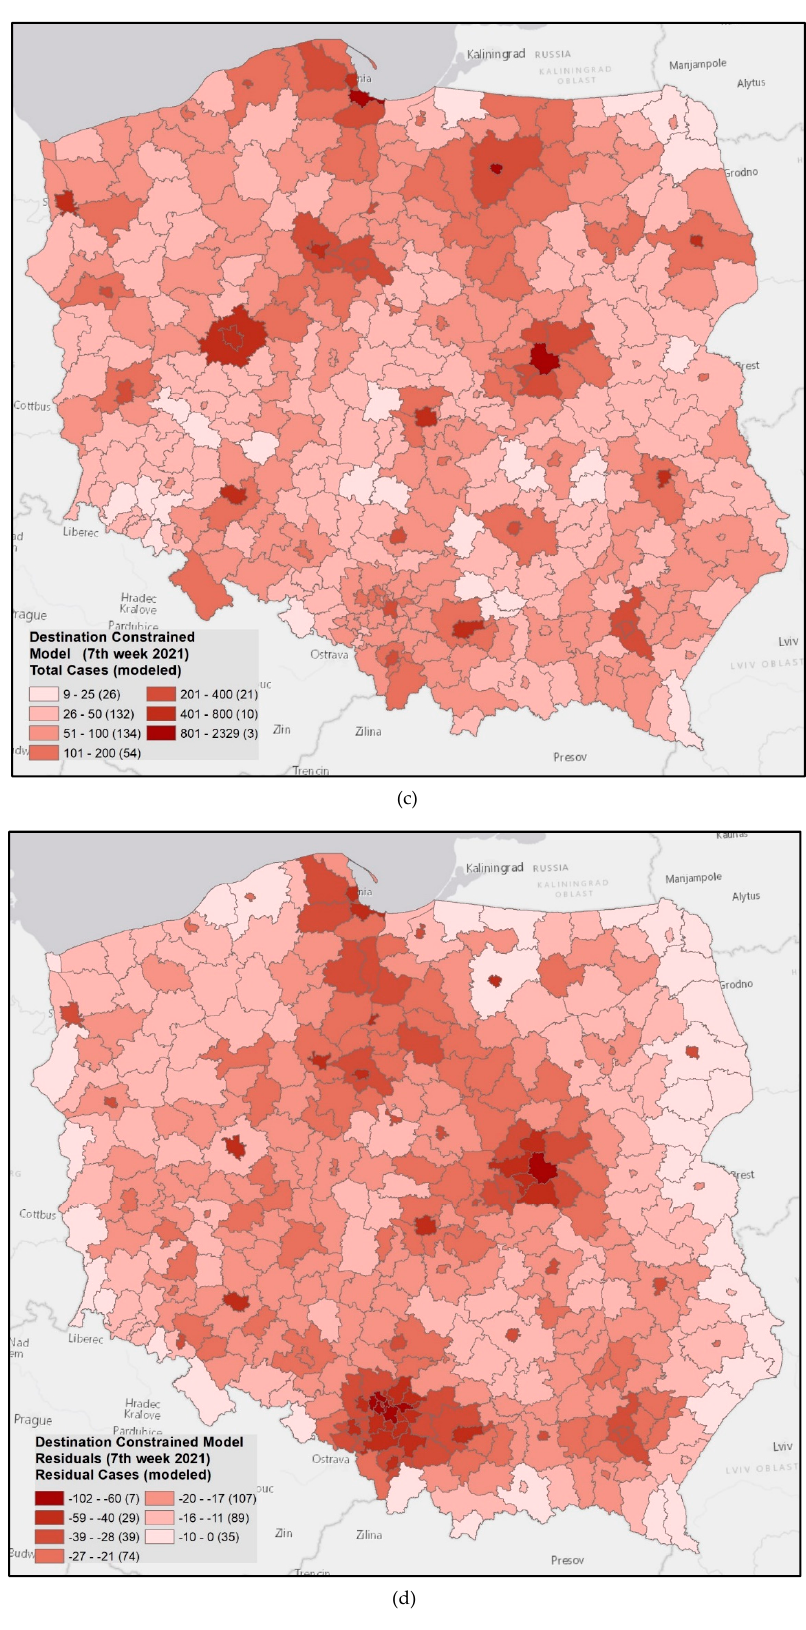
Figure 7. Destination-constrained model: COVID-19 infections in Poland by county; sixth week of 2021—map of the modeled values ( a ) and residuals (( b ), modeled—real value); seventh week of 2021—map of modeled values ( c ) and residuals ( d ).